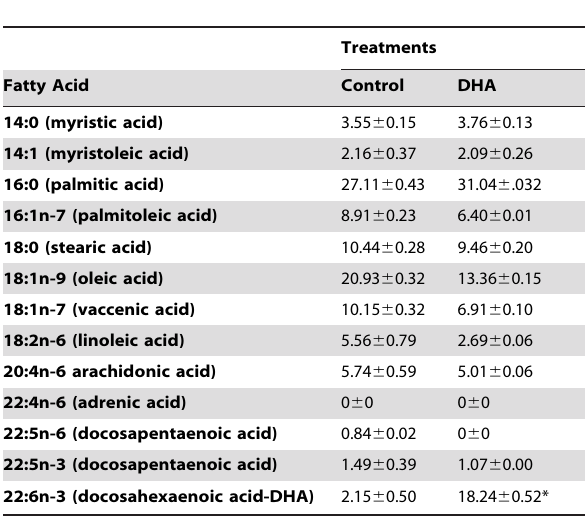
Table 1. Fatty acid composition in phospholipid fractions from fatty acid-treated J774A.1